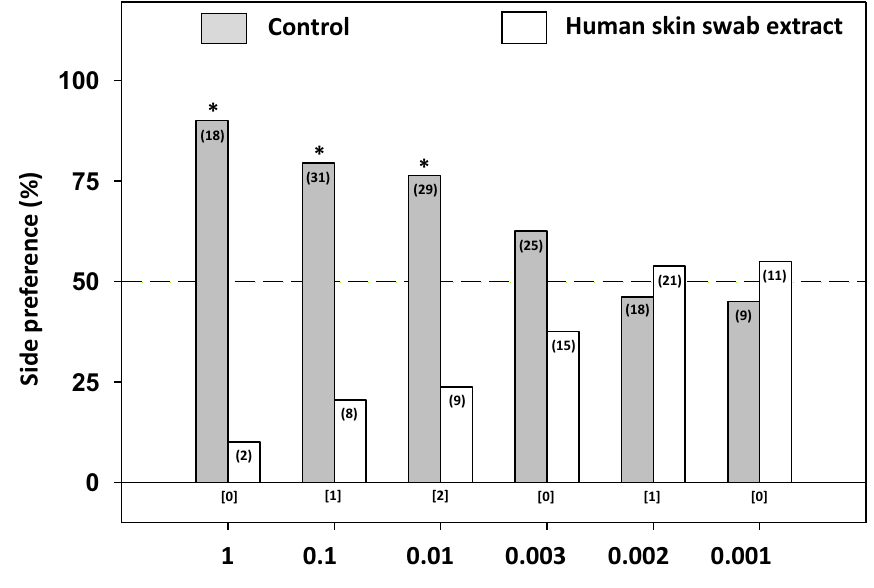
Figure 4. Responses of bed bugs to hexane extracted filter paper skin swabs at different concentrations. One bioassay equivalent is equal to the amount of material present in a standard assay (before extraction). An asterisk (*) indicates a significant preference for one side of the two-choice assay (Chi-square test, P < 0.05). The number of bed bugs that responded is indicated in parentheses for each choice, and the number of that did not respond (i.e., rested on neither of the two shelters) is indicated in brackets below each set of choices for each assay.